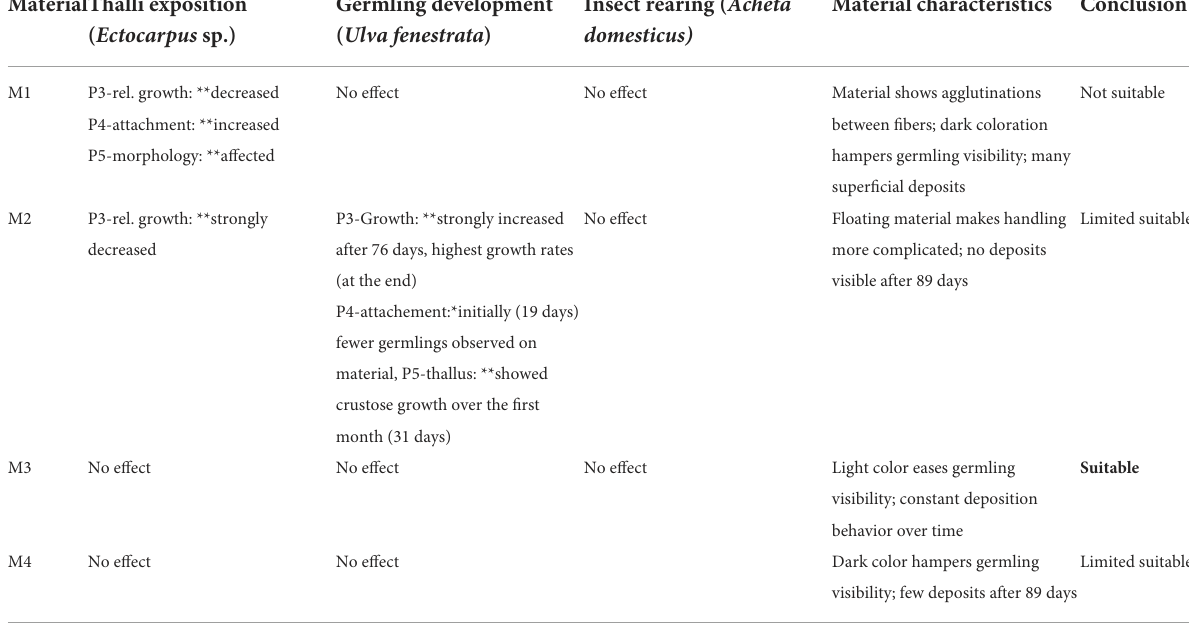
TABLE 3 Results of material exposure to different algae and insects. MaterialThalli